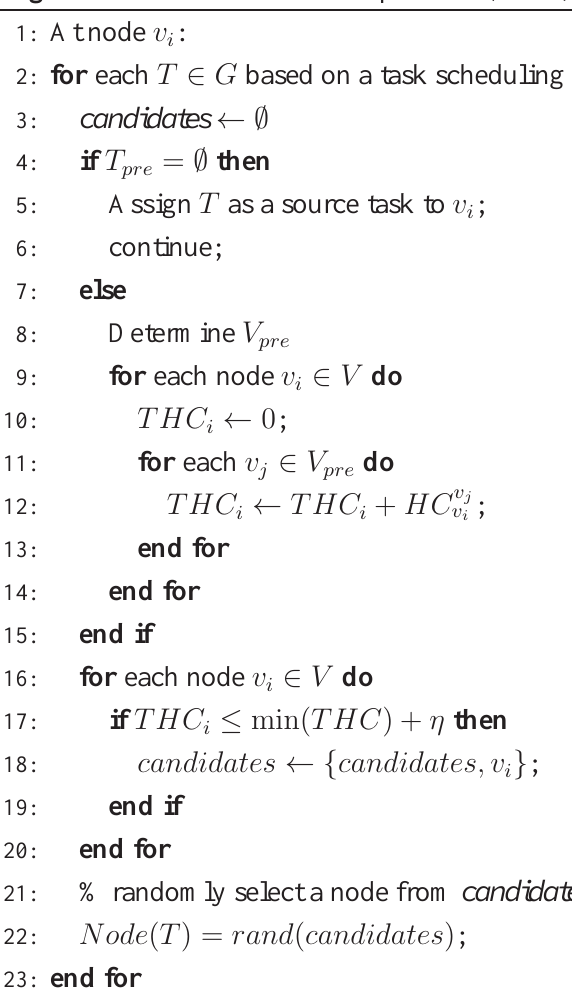
Algorithm 1 The Minimum Hop Count (MHC)